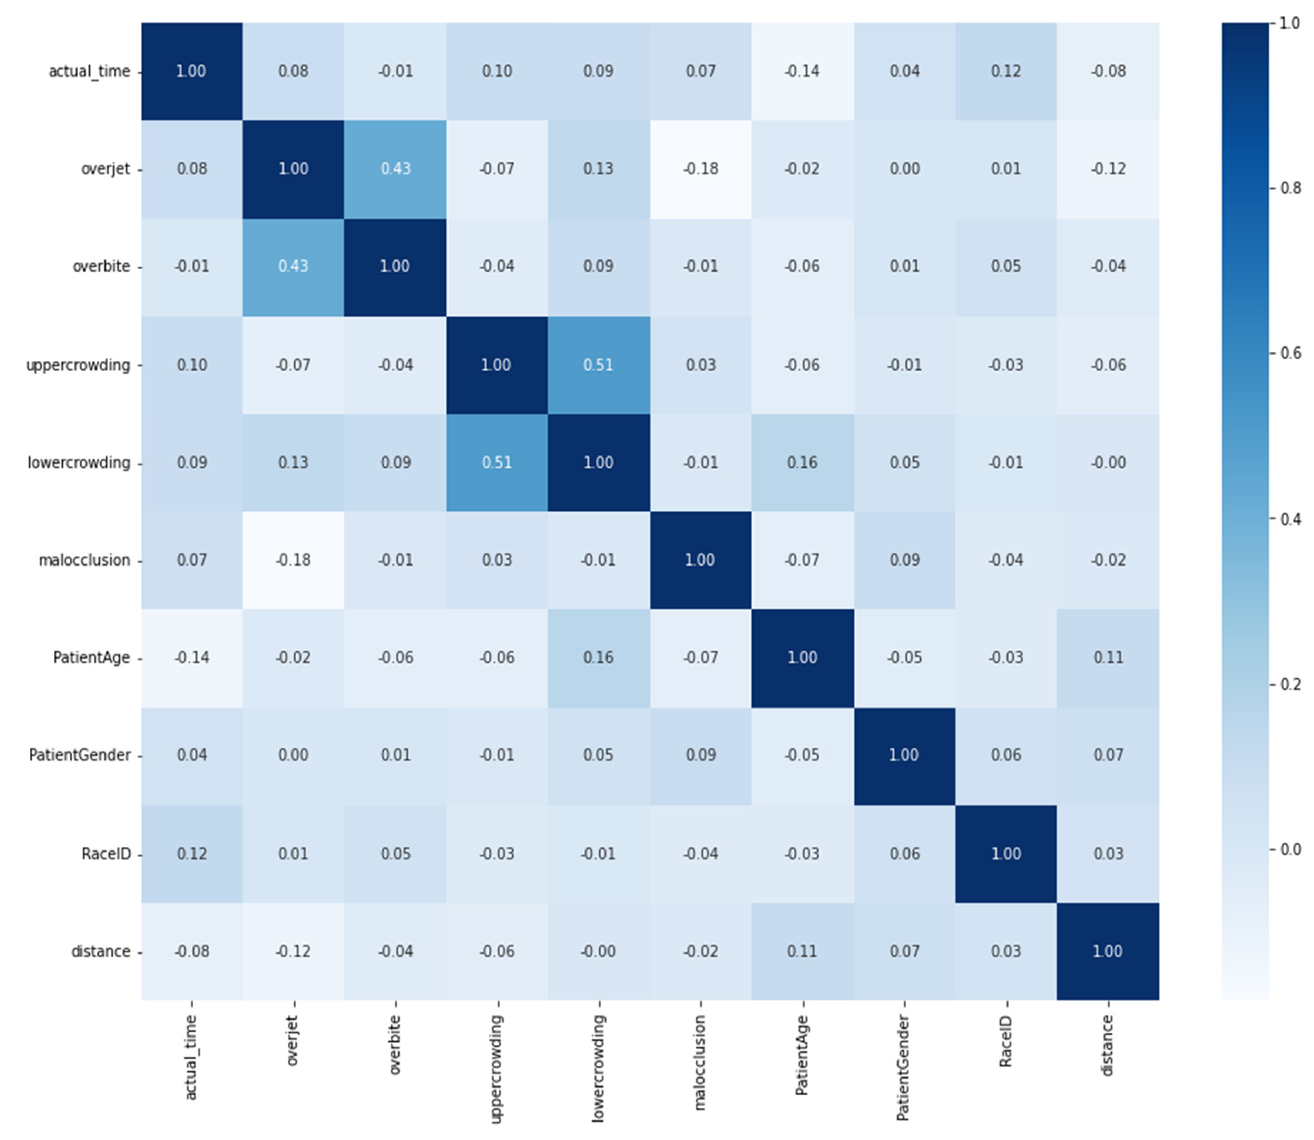
Figure 3. Heat map showing the correlation between variables.